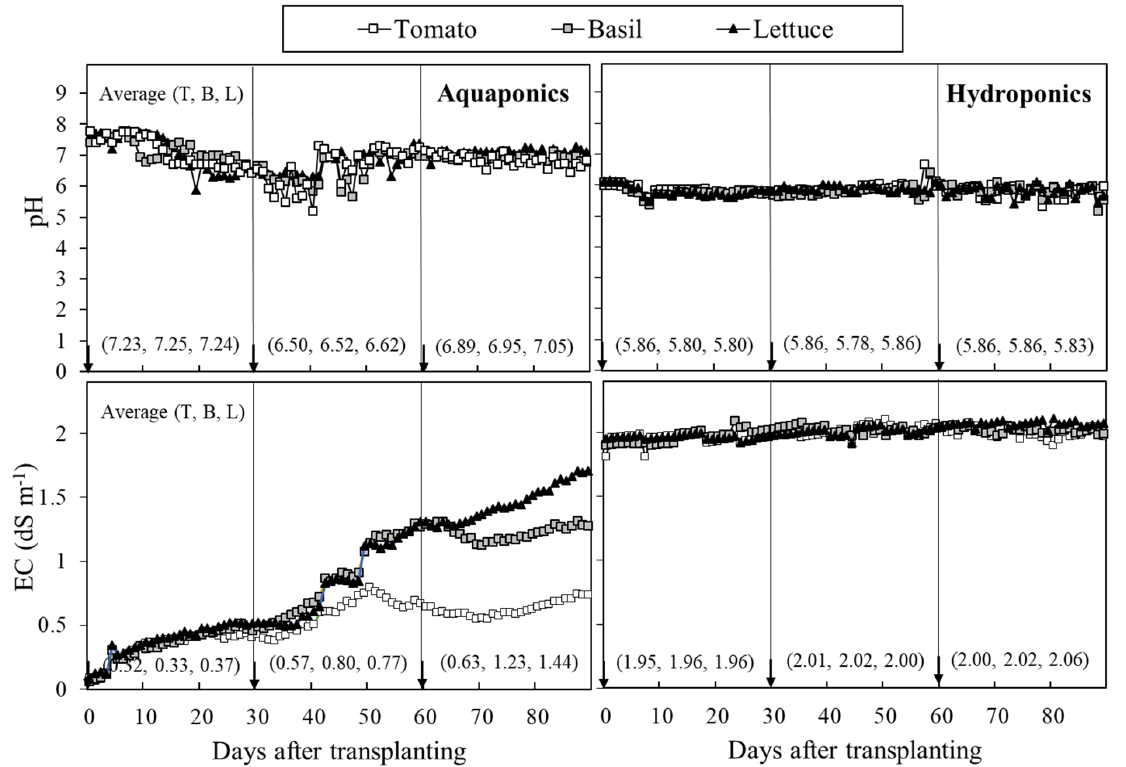
Figure 2. Variations in electrical conductivity (EC) and pH in tomato-, basil-, and lettuce-based aquaponics (left column) and hydroponics (right column) over a 3-month production period. Tomato and basil seedlings were transplanted at day 0, while lettuce seedlings were transplanted at day 0, 30, and 60. Average pH and EC of tomato (T)-, basil (B)-, and lettuce (L)-based systems are given for 30 days in parenthesis. Each data point is the mean of 3 replicates measured from the hydroponic culture unit of each system.